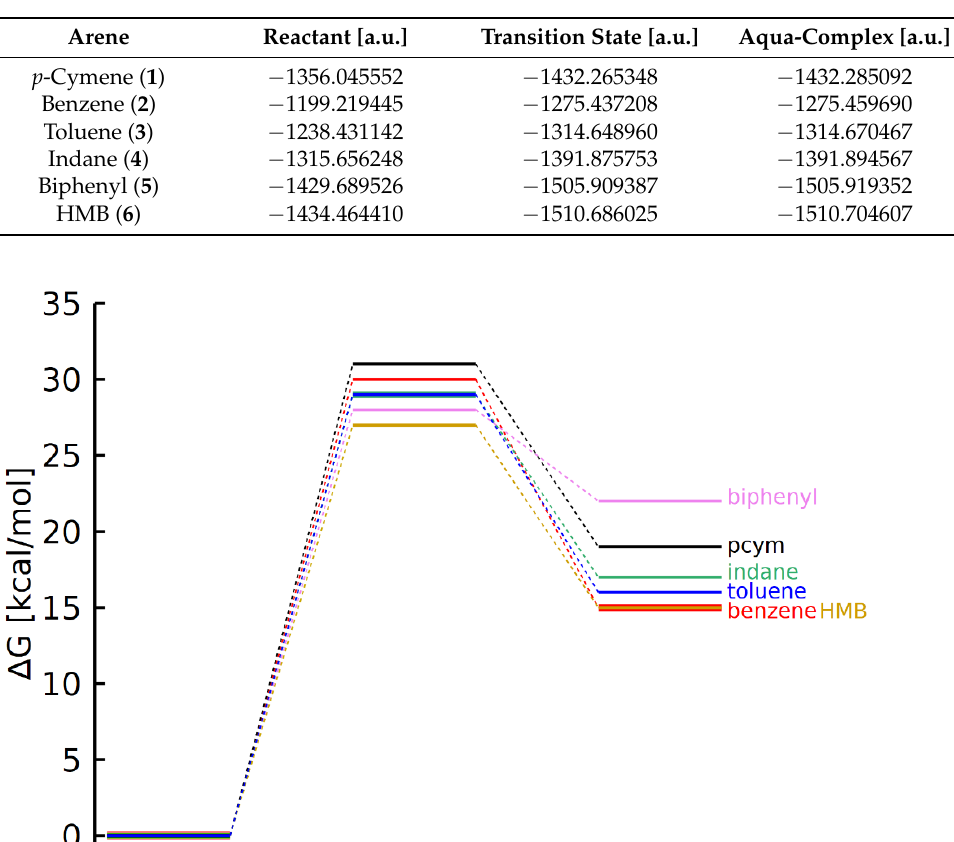
Figure 5. DFT calculations regarding the hydrolysis of complexes ( 1 – 6 ). Relative free energies of complexes ( 1 – 6 ) are set to zero (left) in order to compare the energetic order of the corresponding transition states (middle) and aqua complexes (right).